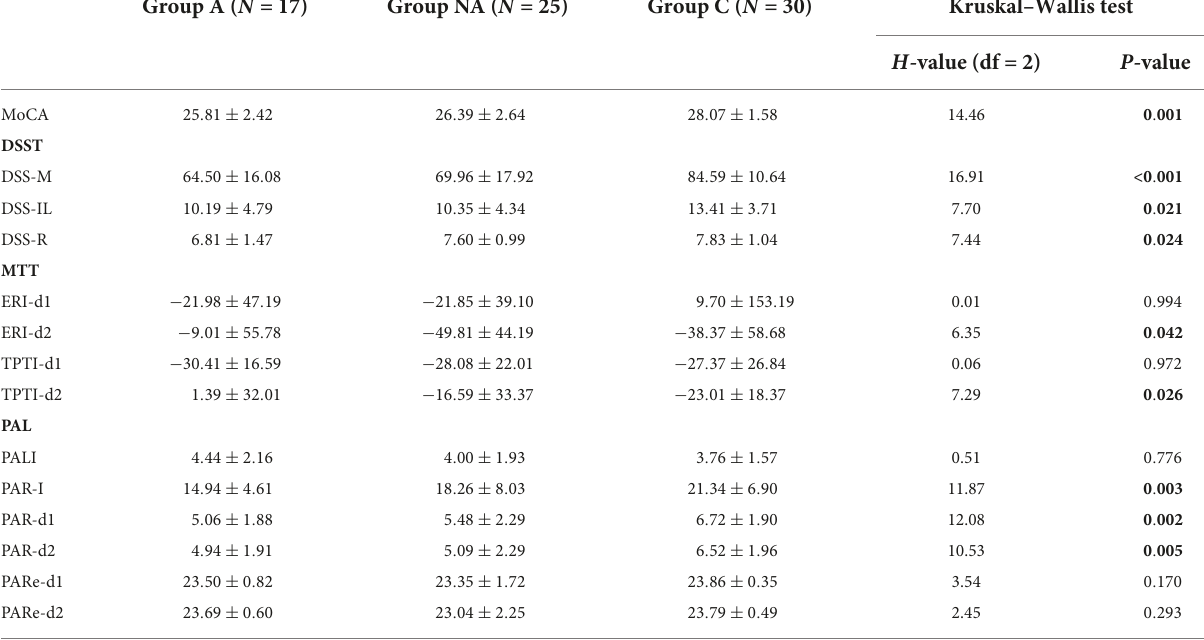
TABLE 2 Mean ± standard deviation of the study variables and group comparisons.